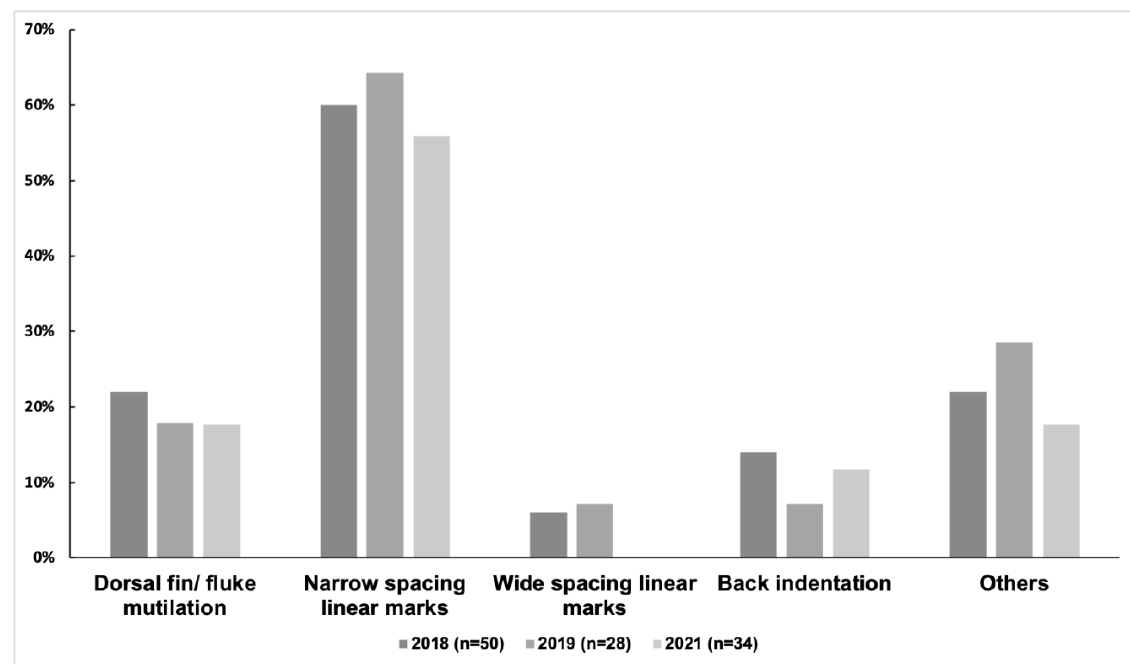
Figure 3. The prevalence of different injury categories in each year (n = 50, 28, and 34).